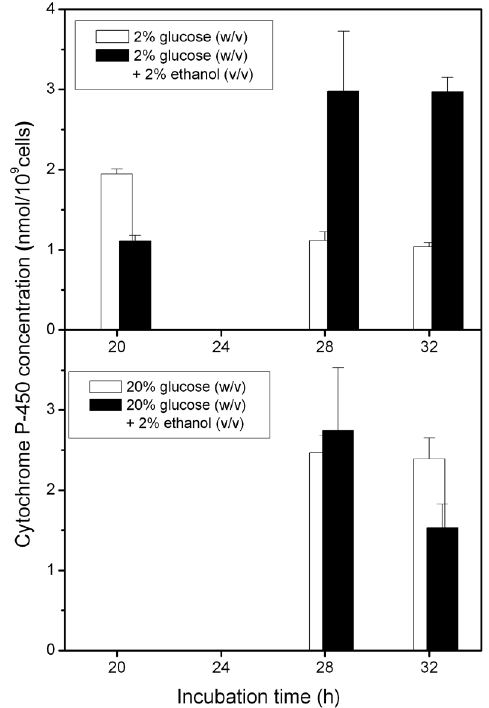
FIGURE 5 - Cytochrome P-450 concentrations of S. cerevisiae strain NCYC 240 cultured in media containing 2 % (w/v) and 20 % (w/v) glucose, in the presence and absence of 2 % ethanol